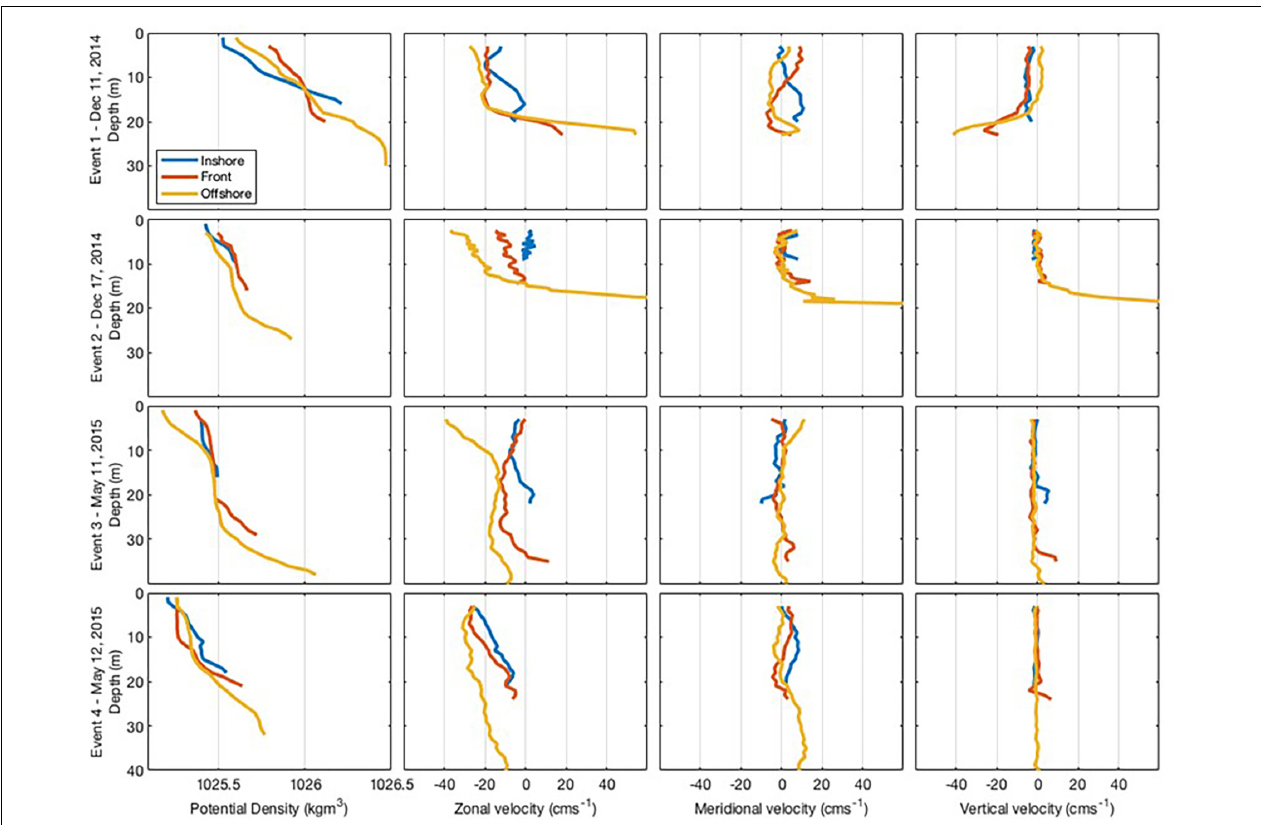
FIGURE 4 | Cross-shore transect for each frontal event showing vertical sections of density, zonal, meridional, and vertical current velocity recorded at each zone within the coastal nearshore of Sardinia Bay region during December 2014–May 2015. Sardinia Bay runs approximately east-west, thus zonal currents are alongshore, with positive values eastward and negative values westward. Meridional currents are across-shore, with positive values northward (toward the coast) and negative values eastward (away from the coast). Positive vertical currents are toward the surface and negative vertical currents are away from the surface.